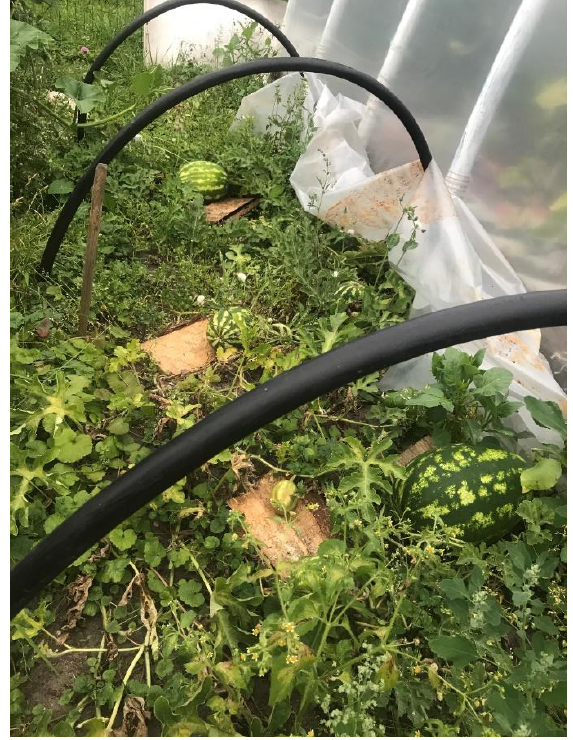
Figure 6. Watermelons in home gardens, Tauragė District.